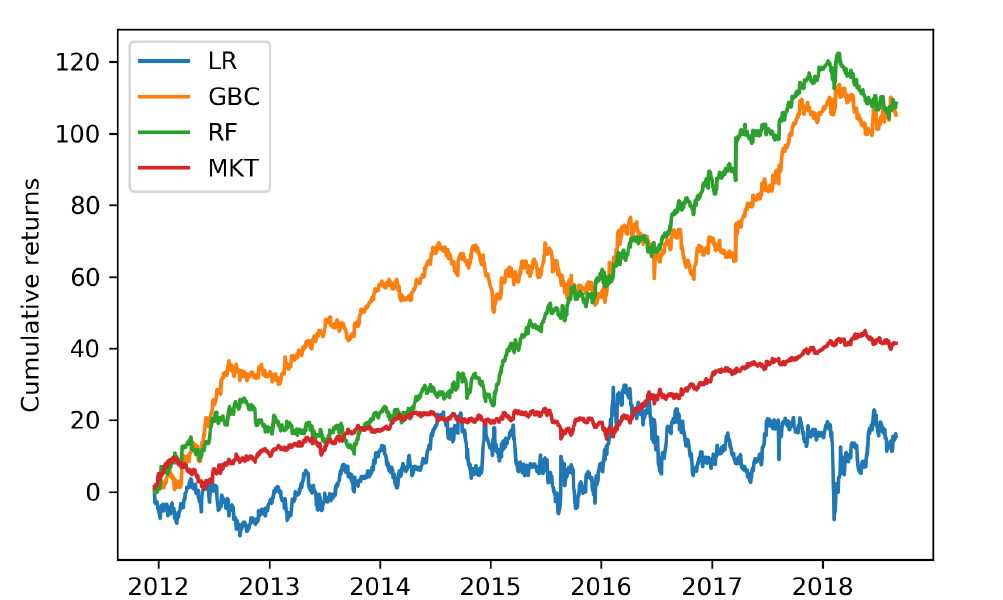
Figure 1. Cumulative returns for baseline strategy. Cumulative returns expressed in percentage terms for the top/flop three trading strategy ( k = 3 ) for the logistic regression (LR), gradient-boosting classifier (GBC), random forest (RF) and general market (MKT) over the seven-period-long trading simulation with a holding period of one day ( h = 1 )